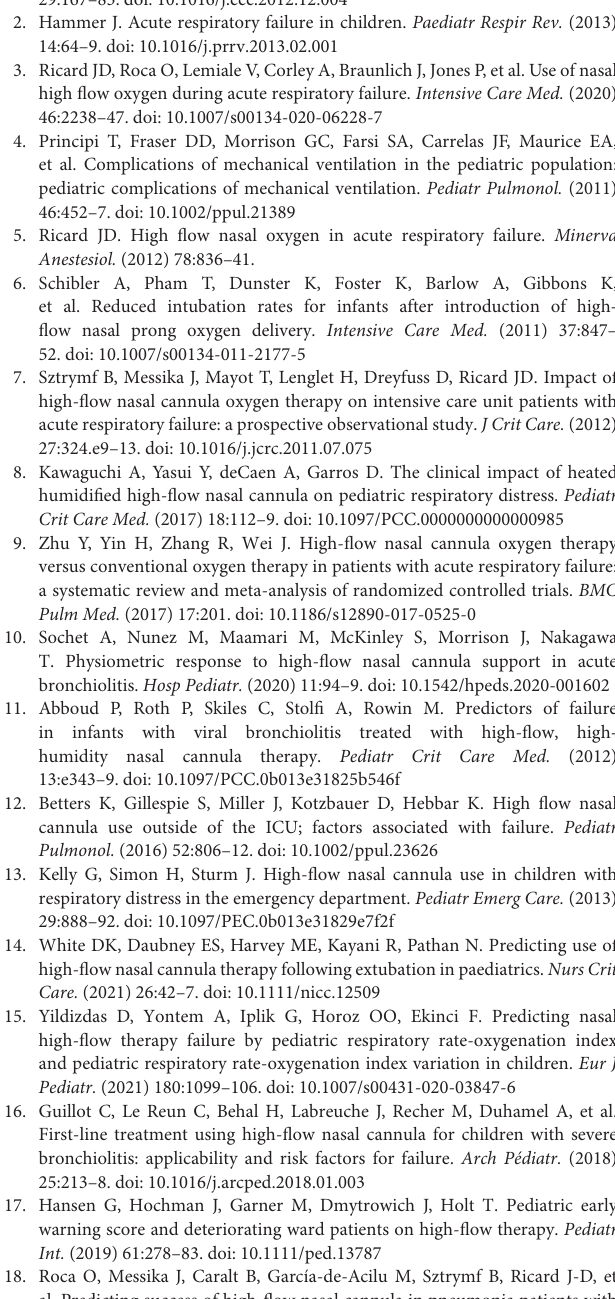
Supplementary Table 1 | Average starting values of oxygen flow rate and fraction of inspired oxygen for each level of respiratory support. Supplementary Table 2 | All of the features used in our model.